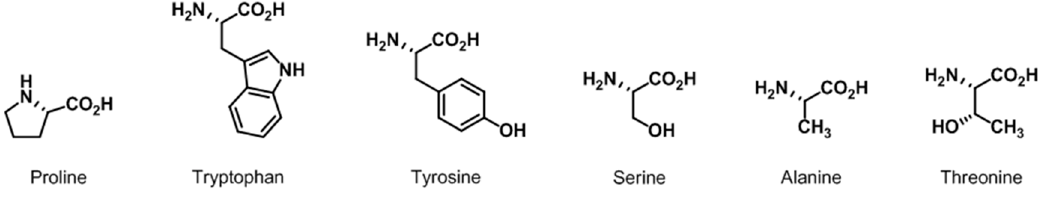
Figure 2. Representative α‐ amino acids.